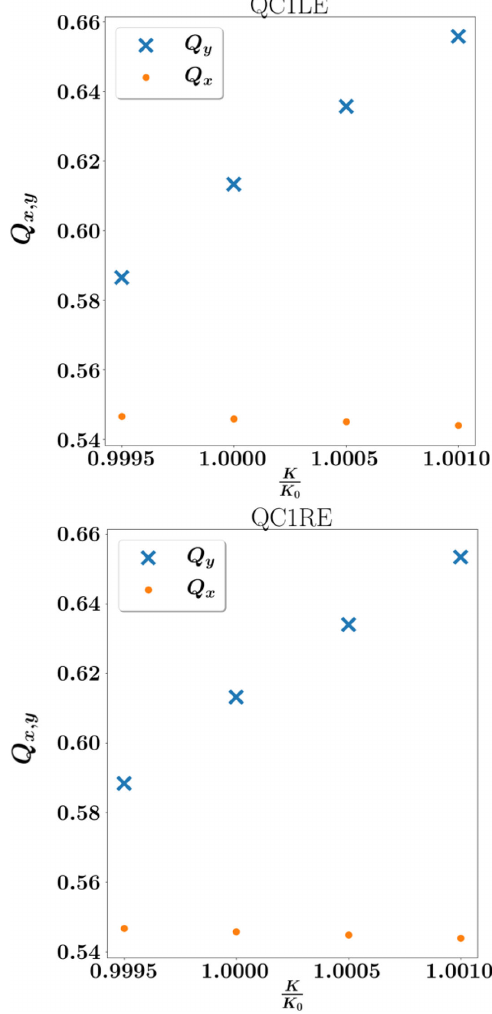
FIG. 17. Measured vertical and horizontal tunes while modu- lating the quadrupole magnets closest to the IP in HER, QC1LE and QC1RE. The smallest separation between the horizontal and vertical tunes is approximately 0.04, which is 20 times larger than the estimated coupling strength during the measurements, j C − j ≈ 0 . 002 , see Fig. 15. The integrated strength of the magnets during the measurements were KL 0 ¼ − 1 . 15 m − 1 for QC1LE and KL 0 ¼ − 1 . 09 m − 1 for QC1RE.